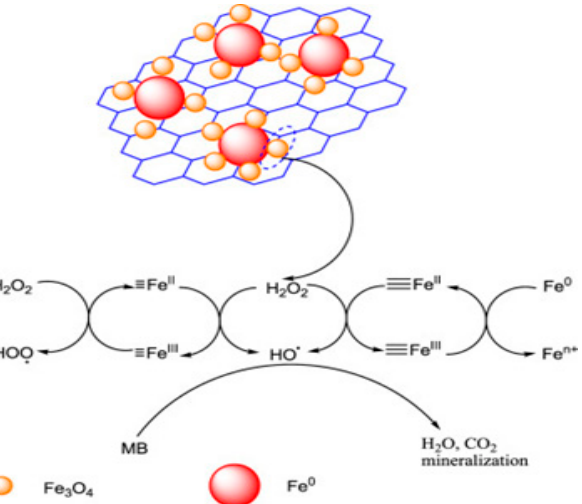
Figure 4. The possible Fenton catalytic oxidation process. Reproduced with permission from Else- vier [63].